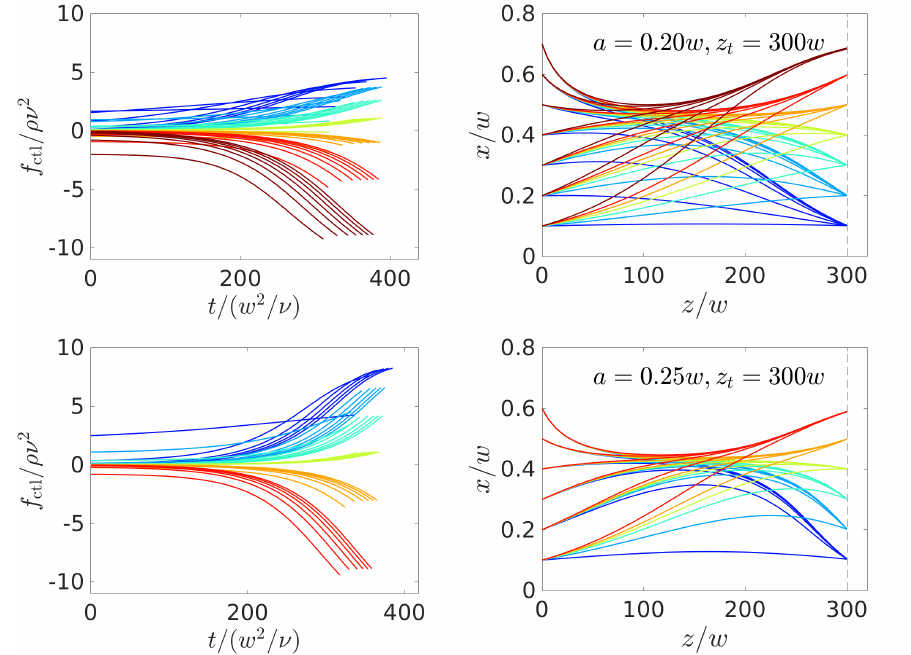
0.1,0.2,0.3,0.4,0.5,0.6 . { }